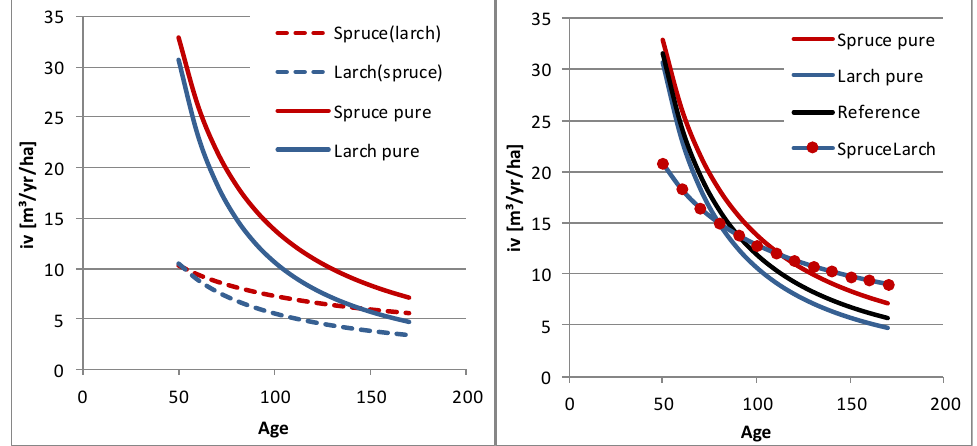
Figure 4. Volume growth of spruce and larch at a spruce proportion of 40%, depending on the stand age ( left template ). Spruce (larch) indicates the growth of spruce when admixed with larch, and Larch (spruce) indicates the growth of larch when admixed with spruce. SpruceLarch ( right template ) indicates the total growth of spruce and larch in the mixed stand, while the reference is the growth in the hypothetical mixed stand if there were no mixing effects.